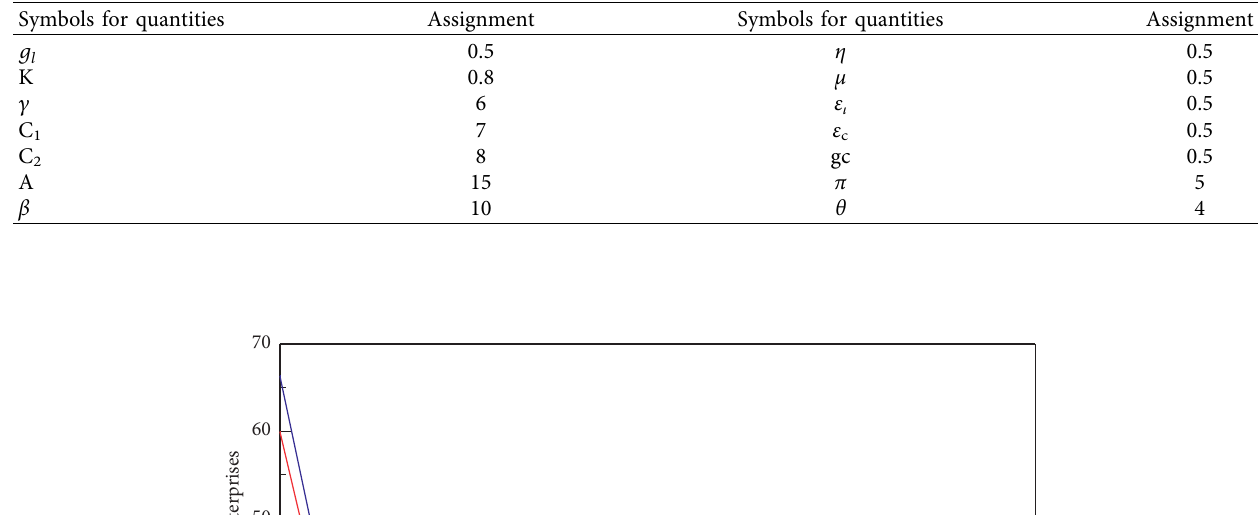
Table 2: Parameter assignment.